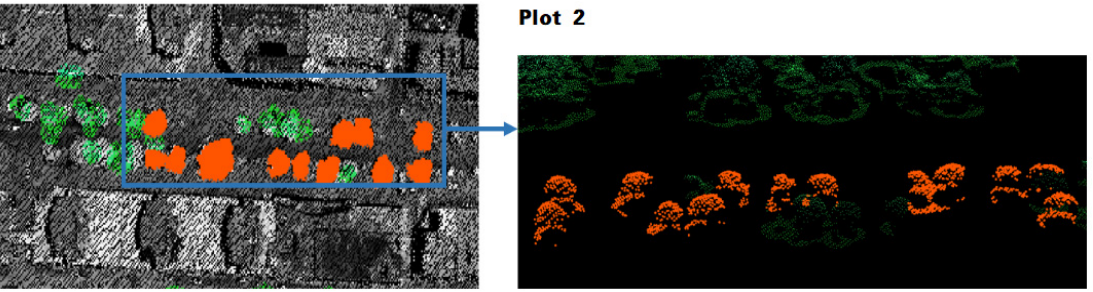
Figure 9. Trees that were not extracted (orange points).